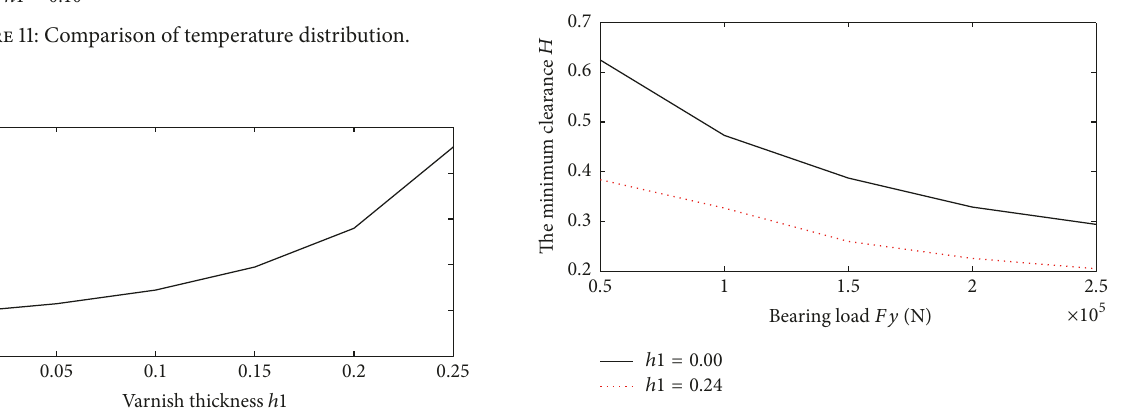
Figure 14: Variation of the minimum oil film thickness with bearing